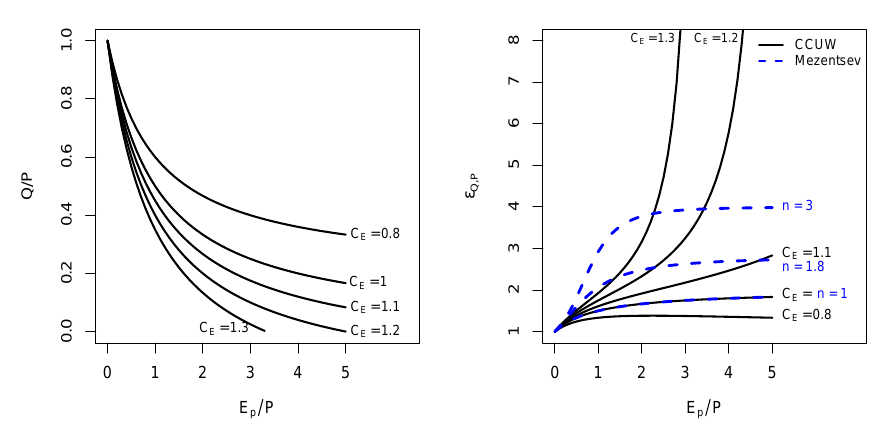
Fig. 6. Left panel: runoff ratio as a function of aridity for different, but fixed values of catchment efficiency ( C E ) using Eq. (26). Right panel: elasticity coefficient of streamflow to precipitation ε Q,P as a function of aridity. Displayed are the elasticities derived from the CCUW hypothesis (black for different values of C E ), and the elasticities derived from different parameterisations of the Mezentsev functions using Eq.